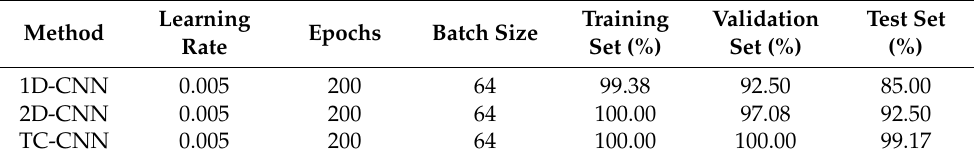
Table 6. The comparison of defect recognition